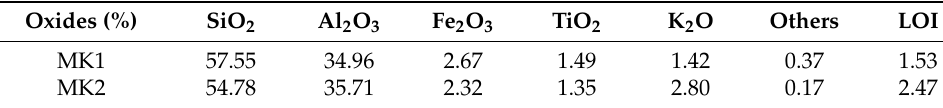
Table 1. Chemical compositions (% in mass) of MK1 and